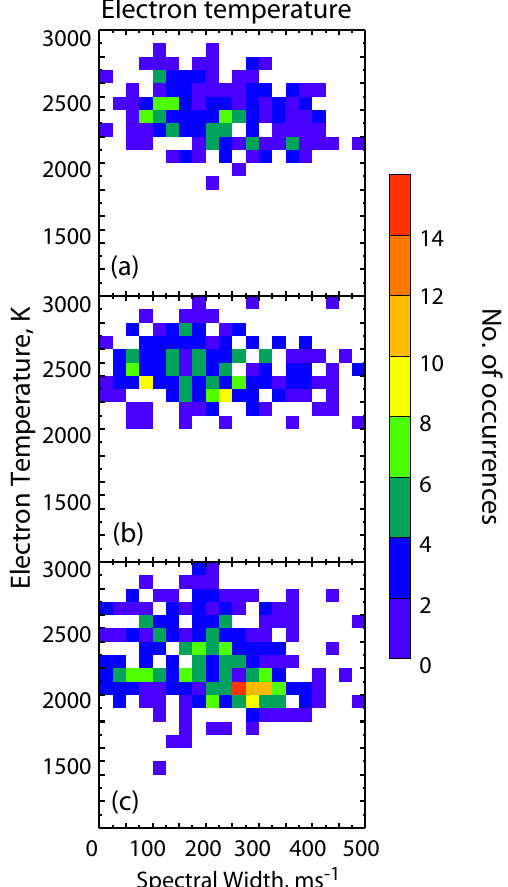
Fig. 11. Electron temperature from the two mainland EISCAT beams and the ESR beam, vs. spectral width from the CUTLASS Finland radar. The data is restricted to 71 ◦ to 72 ◦ latitude AACGM to cover only a small range of altitudes in the F-region from all of the radar beams. Row (a) EISCAT beam 1, (b) EISCAT beam 2, and (c) ESR.